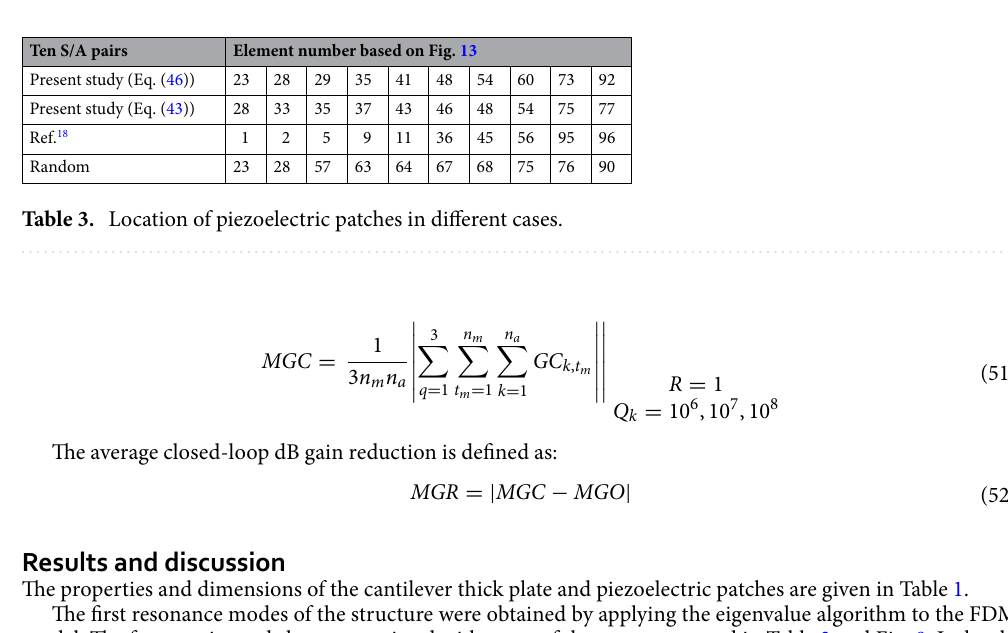
Figure12. The first six modal shapes of the plate by FORTRAN.